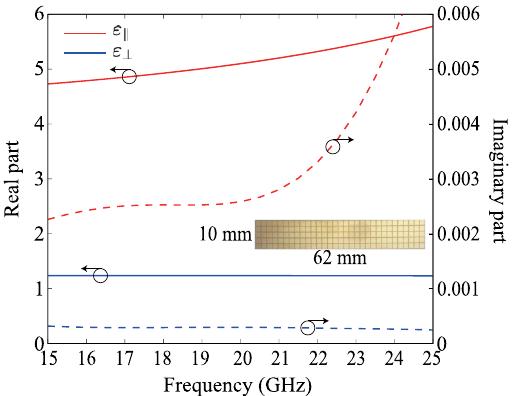
Fig. 2. Retrieved permittivity (simulation). The red solid and dashed lines represent the real and imaginary parts of e k , respectively. The blue lines represent those for e ⊥ . The design frequency is 18.25GHz. Inset: photograph of the designed arti fi cial